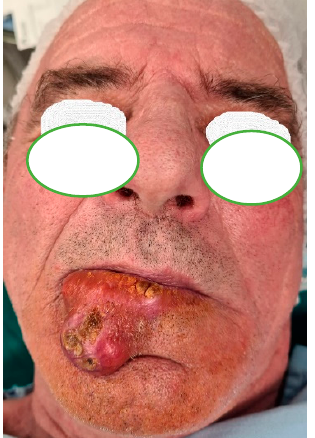
Figure 4. 2/3 Inferior lip squamous cell carcinoma .